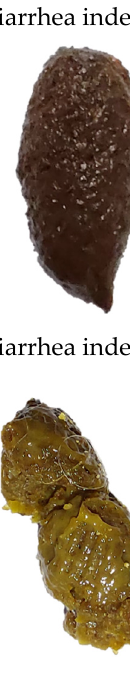
Figure 2. Morphology of stool in different diarrhea index.